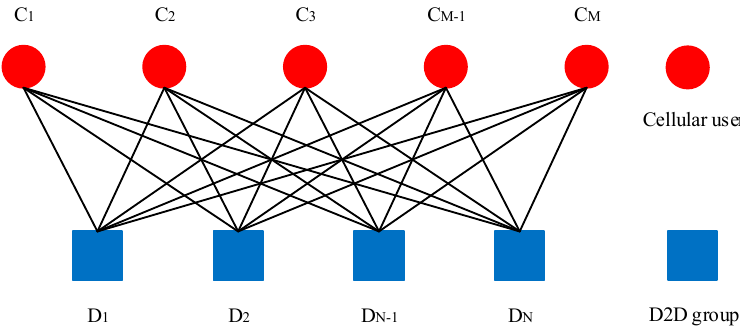
Figure 2. Bipartite graph for matching problem.